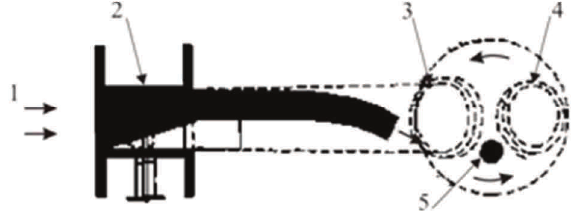
Fig. 2. The schematic view of swirl generation system [13]: 1 – direction of air-fuel mixture inlet, 2 – swirl regulation valve, 3 – inlet valve, 4 – exhaust valve, 5 – spark plug